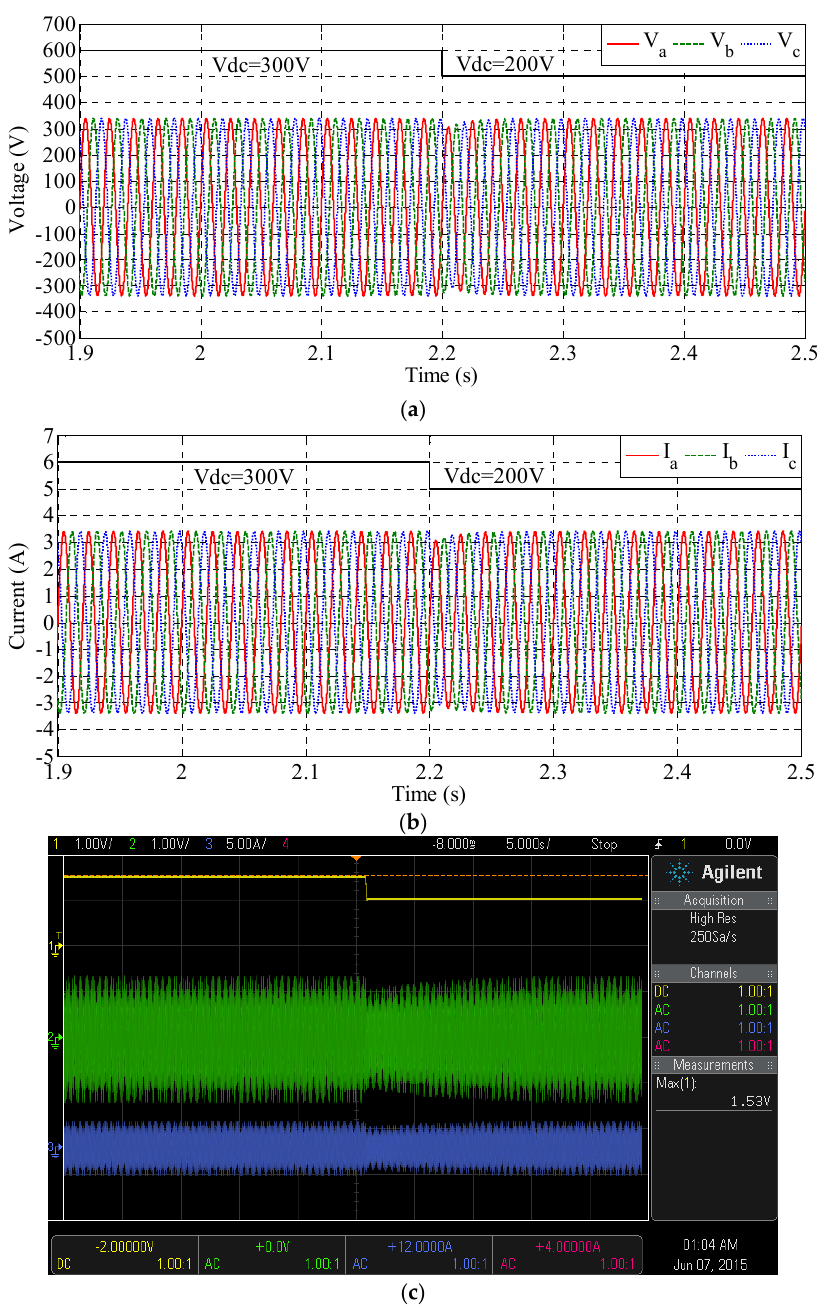
Figure 21. Waveforms with V dc decreasing from 300 V to 200 V with R load. ( a ) Simulation voltage waveforms; ( b ) simulation current waveforms; and ( c ) experimental voltage and current waveforms (Ch. 1, Ch. 2, and Ch. 3 for V dc , V a , and I a ,